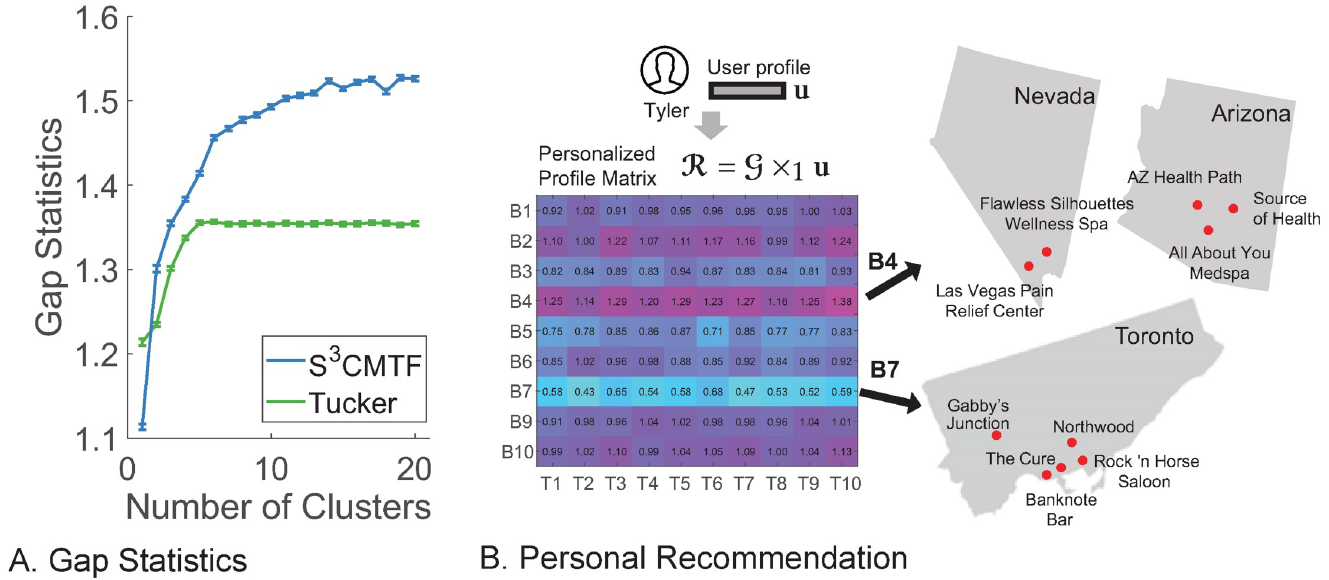
Fig 7. (a) Gap statistics on U (2) of S 3 CMTF and the Tucker decomposition for Yelp dataset. S 3 CMTF outperforms the naive Tucker decomposition for its clustering ability. (b) Visualization of the personal recommendation scenario.